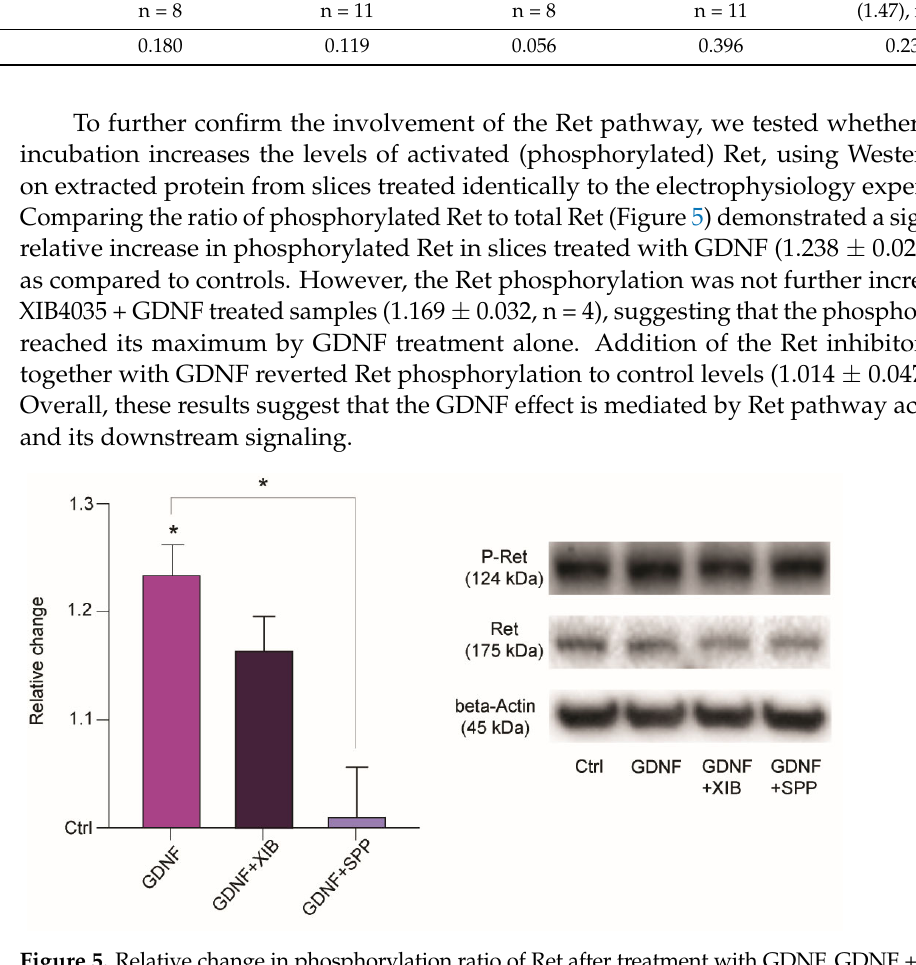
Figure 5. Relative change in phosphorylation ratio of Ret after treatment with GDNF, GDNF + XIB4035 and GDNF + SPP compared to control. Example images of Western blot membrane staining depicted to the right. Data represented as mean and SEM. Friedman test–*** p < 0.001, Dunn’s multiple comparisons test-GDNF to control, * p < 0.05; GDNF + SPP to GDNF, * p < 0.05; n = 4 for each condition.